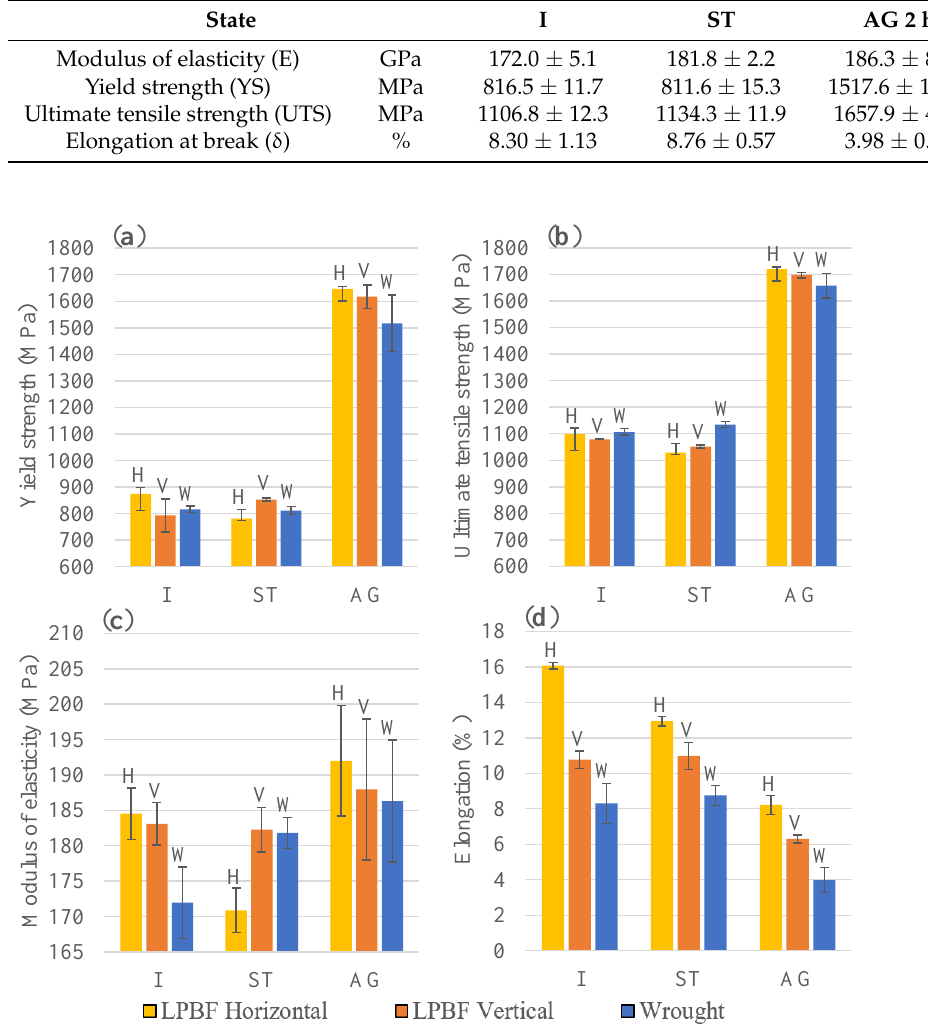
Figure 5. Mechanical properties of the LPBF (H—horizontal and V—vertical) and wrought (W) alloys at different process states: I (initial), ST (solution-treated) and AG (aged, 2 h): ( a ) Yield strength (YS), ( b ) Ultimate tensile strength (UTS), ( c ) Modulus of elasticity (E), ( d ) Elongation at break (δ). For both alloys, the highest strength characteristics (YS and UTS) are provided by the aged samples. For the LPBF alloy, aging increased the YS value by over 88%, and for the UTS, by over 57%, when compared to the initial state. This improvement is achieved at the expense of the material ductility: for the horizontal and vertical LPBF samples, the elongation at break is reduced by 49 and 41%, respectively. The same trend is observed for the wrought alloy: aging increased the YS value by over 86%, and for the UTS, by over 46%, when compared to the initial state, while the elongation at break was reduced by